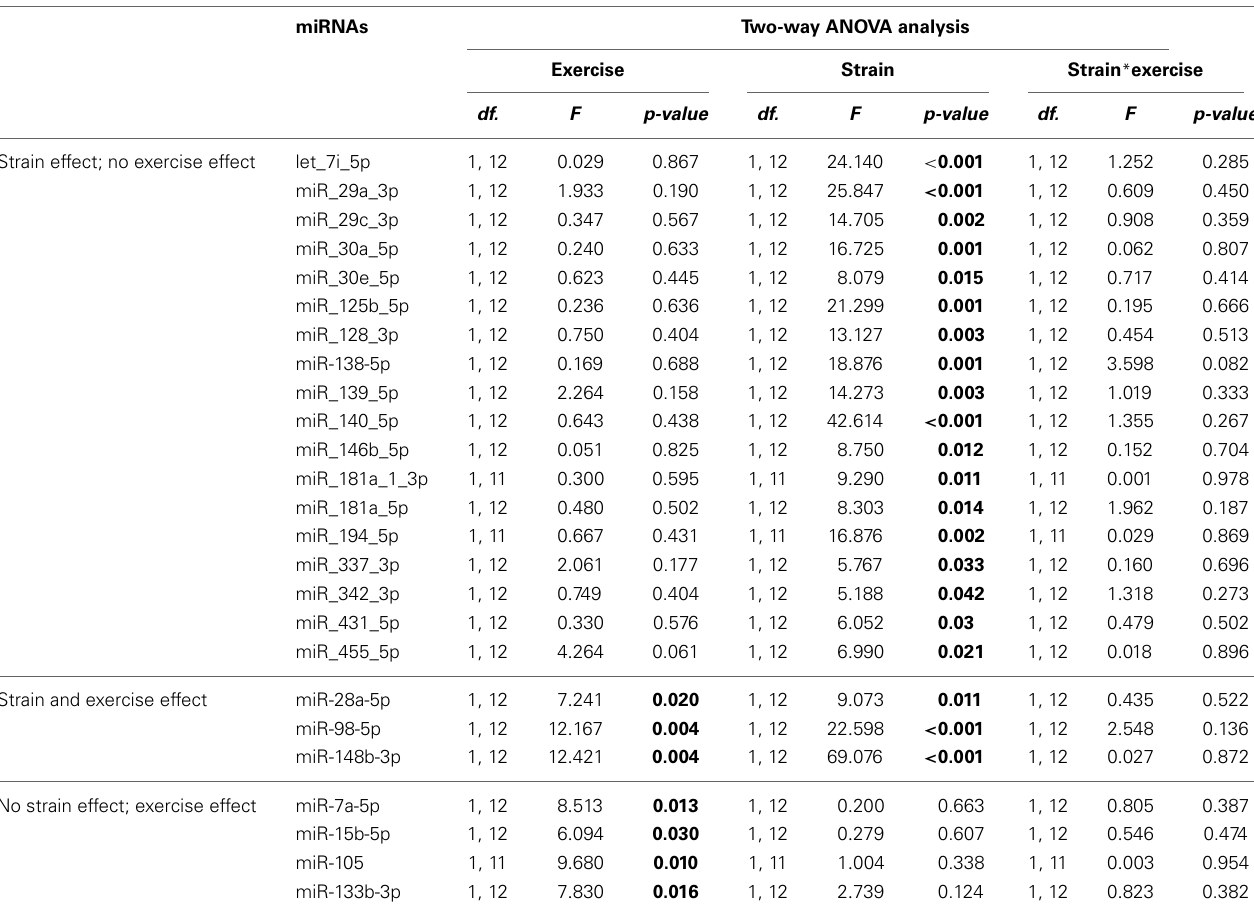
Table 2 | miRNAs significantly altered in SAMP8 mice and/or modulated by exercise. miRNAs Two-way ANOVA analysis Exercise